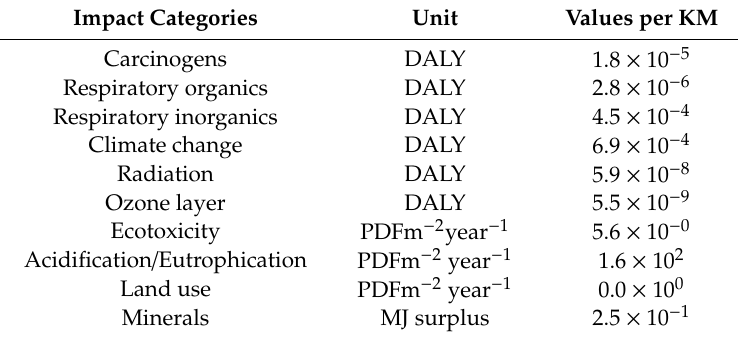
Table 3. Total transport damage characterization per impact